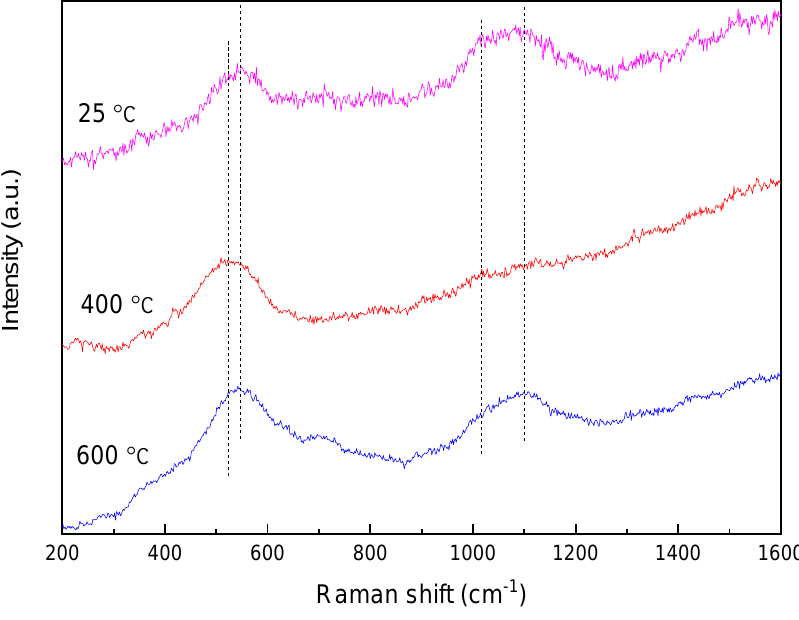
Figure 8. Raman spectra of the alloy with 5% Ti addition at different temperatures.